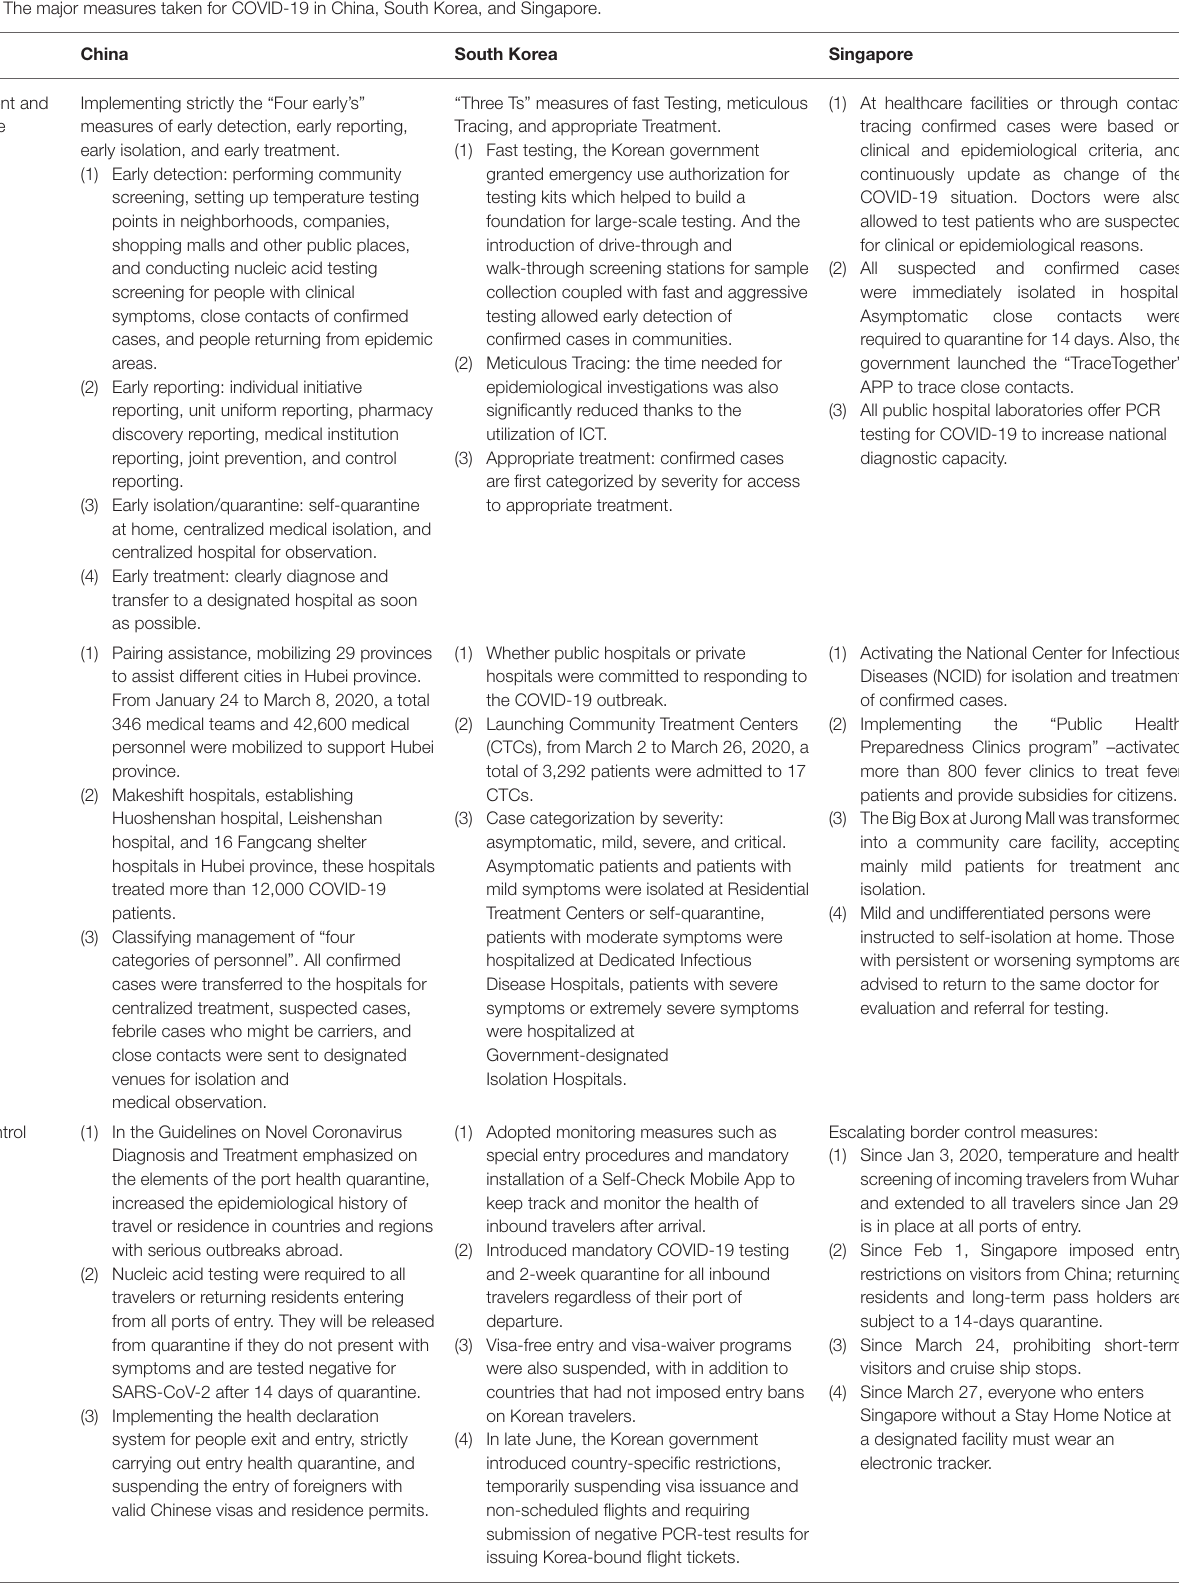
TABLE 1 | The major measures taken for COVID-19 in China, South Korea, and